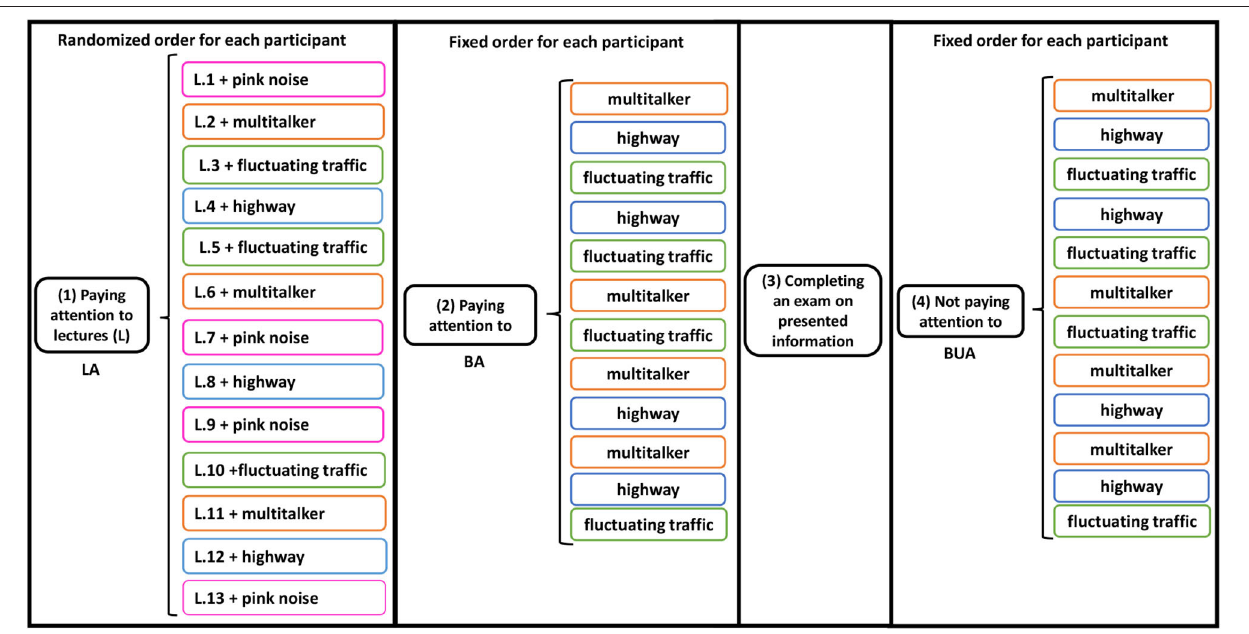
FIGURE 1 | Schematic of experimental protocol and auditory stimuli presentation. Three sequential listening tasks were performed: (1) Lecture attended (LA), (2) Background attended (BA), and (3) Background unattended (BUA). In first task, in addition to multi-talker, highway and fluctuating traffic sounds as the background noises, the lectures were also presented in pink noise and without any background noise. After second task, a written exam was asked to complete about vocal information in the first task. Equivalent levels of background noise and lecture were ∼ 63 and 68 dB(A), respectively. The lectures were are shown by L. i , i = 1, ... ,13, and the noises are distinguished by different colors in the figure.